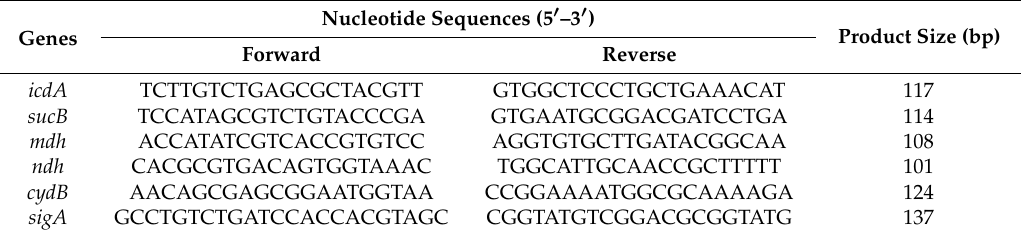
Table 3. Primers in quantitative real-time PCR for B. subtilis WB800.